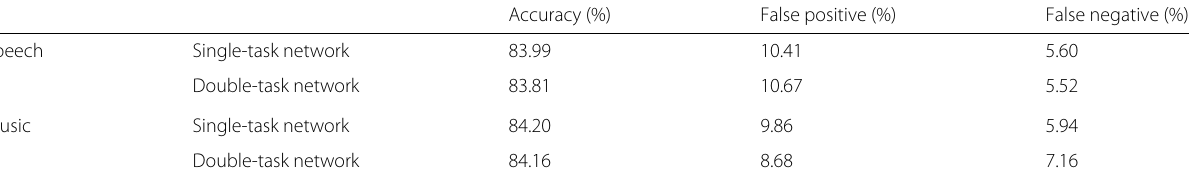
Table 7 Comparison of the event detection results obtained by the best single-task networks and the best double-task network